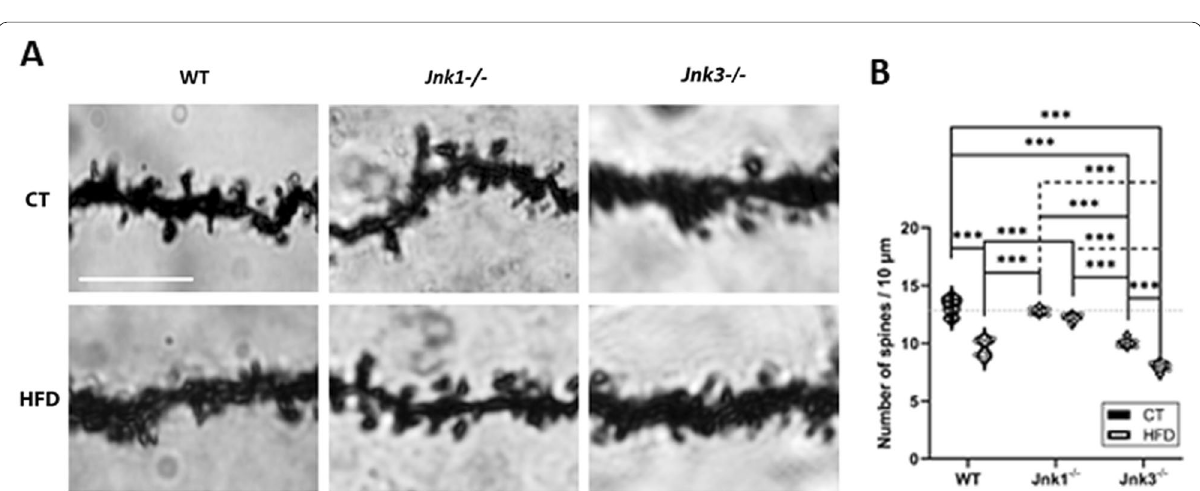
Fig. 4 Hippocampal cognition biomarkers are affected by loss of JNK1 and JNK3. A and B Changes in Cognition‑related genes (n experimental group). Results were represented as bar graphs. Differences between groups were analyzed using ANOVA and Tukey’s. Significance was represented as follows: *p < 0.05, **p < 0.01 and ***p < 0.001